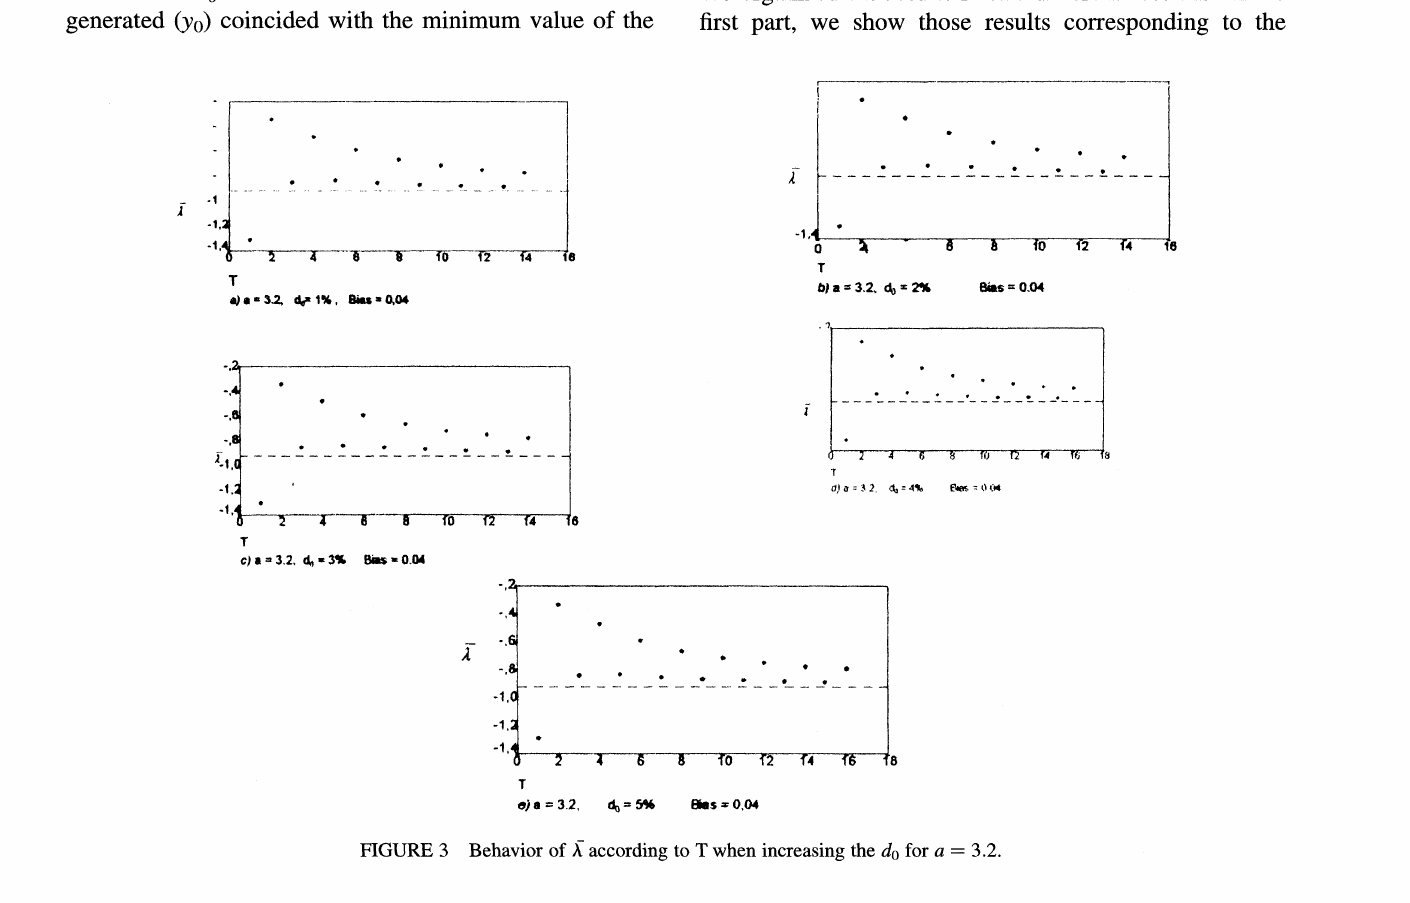
FIGURE 3 Behavior of X according to T when increasing the do for a